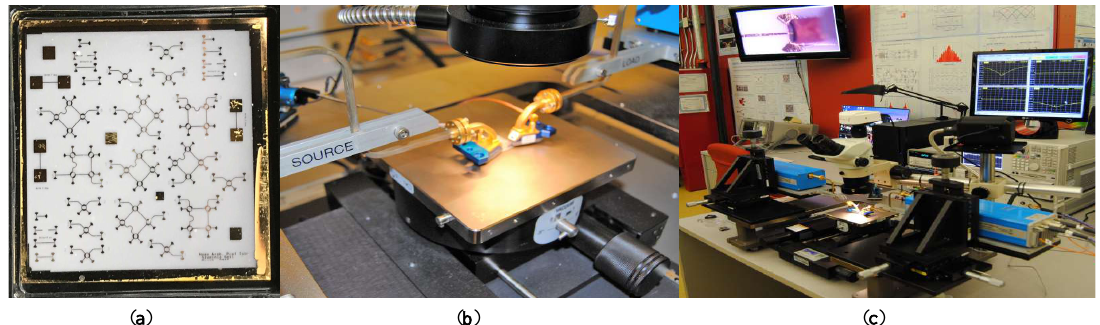
Figure 4. ( a ) The coplanar probe with a pitch of 150 µ m. ( b ) The fabricated circuit for full-port characterization. ( c ) Two-port mm-wave measurement